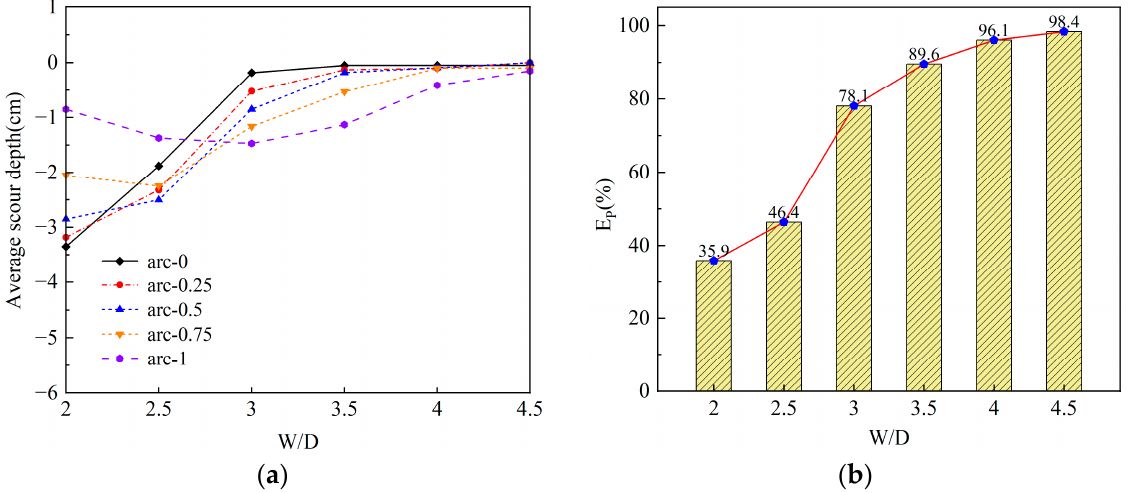
Figure 15 . ( a ) Variation of average scour depth with collar diameter. ( b ) Variation of reduction efficiency with collar diameter.